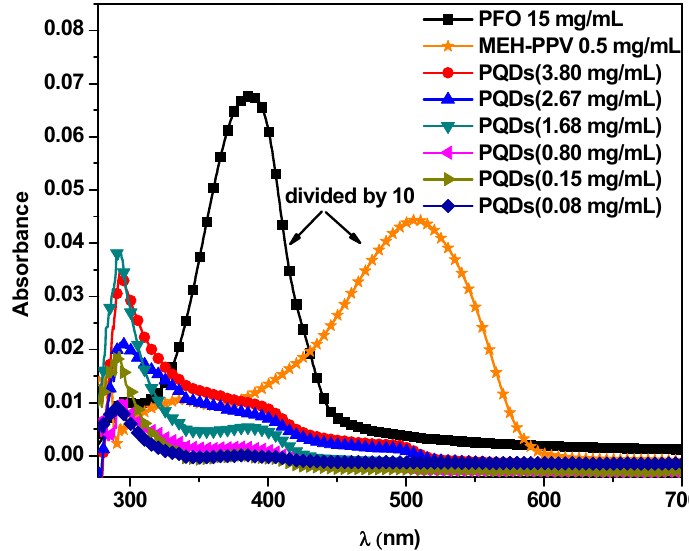
Figure 1. Absorption spectra of pristine PFO, MEH-PPV, and perovskite quantum dots (PQDs) at specific concentrations that were equal to the ratios utilized for the hybrids .